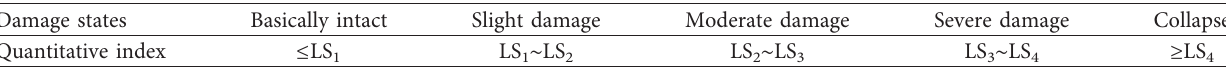
Table 7: Damage states and quantitative index.